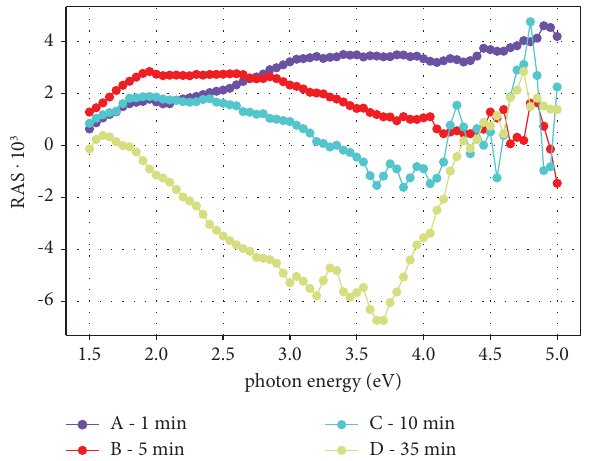
Figure 3: RAS spectra for samples A, B, C and D lines are just guide to the eyes.